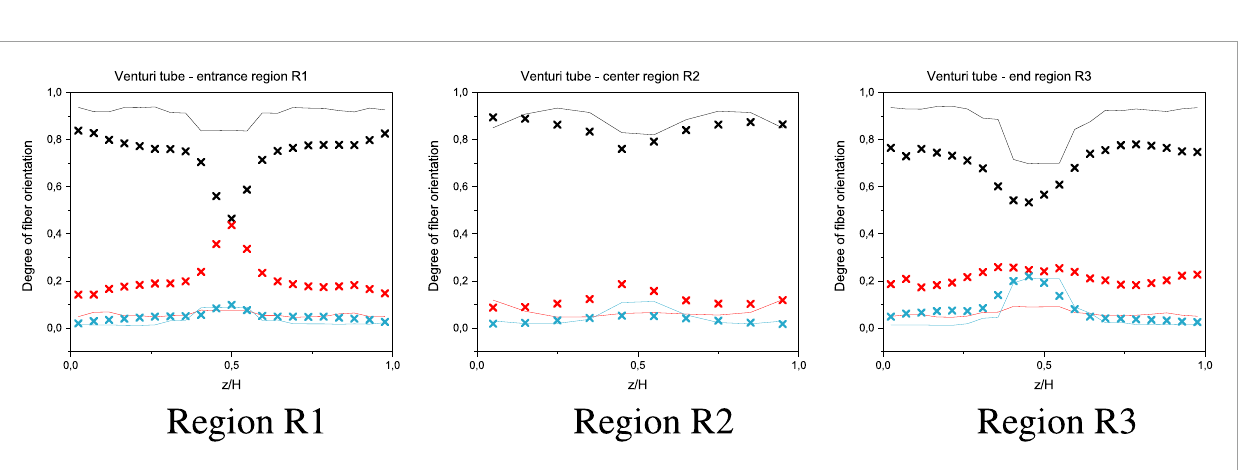
FIGURE 9 Fiber orientation distributions using the iARD-model with 3 parameters optimized for R2 (center) X : CT measurements, lines: simulation results, fiber orientation directions: black: xx (in-flow), red: yy (across flow), teal: zz (through-thickness).